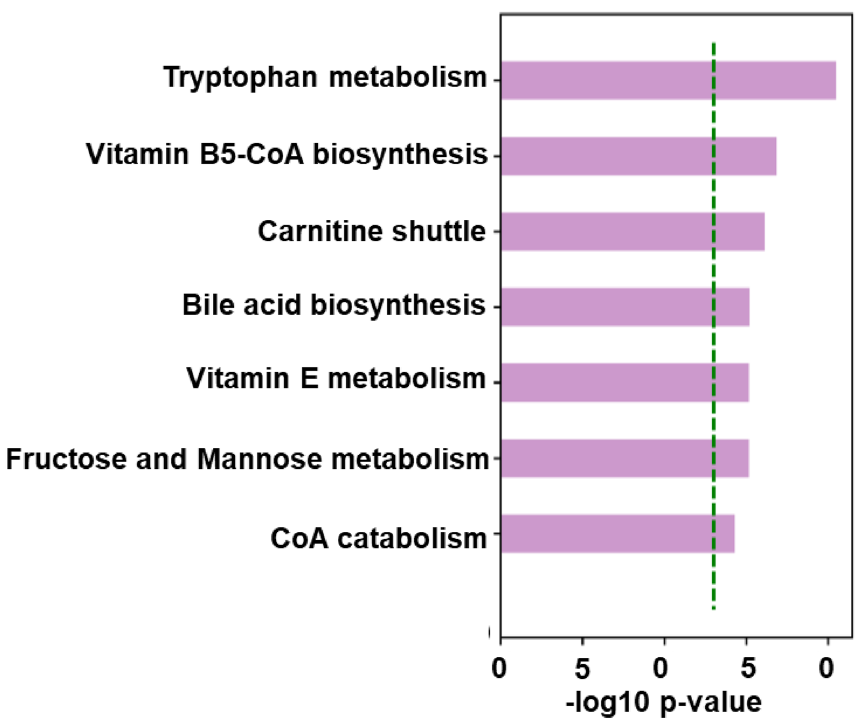
Figure 3. Pathway Analysis using significant metabolites observed in the linear regression (raw p <